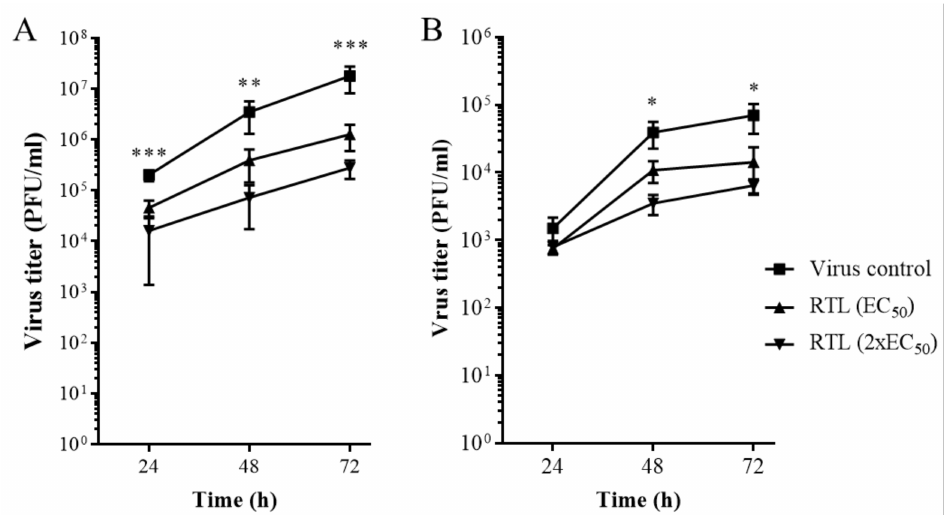
Figure 5. RTL inhibits ZIKV virus replication in hNSCs. ( A ) Extra-cellular and ( B ) intra-cellular virus titer in hNSCs following ZIKV infection and RTL treatment at EC50 and 2xEC50 doses were measured at different time intervals. Each line graph represents the mean ± SD of ( A ) two individual experiments of six individual wells and ( B ) three individual wells of a single experiment. * p < 0.05; ** p < 0.01; and *** p < 0.001 by one-way ANOVA using Dunnett’s multiple comparison test at each time